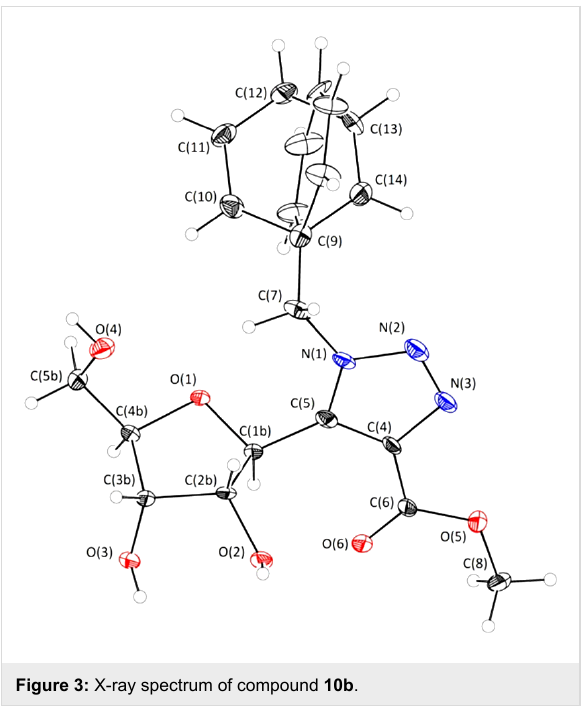
Figure 3: X-ray spectrum of compound 10b .